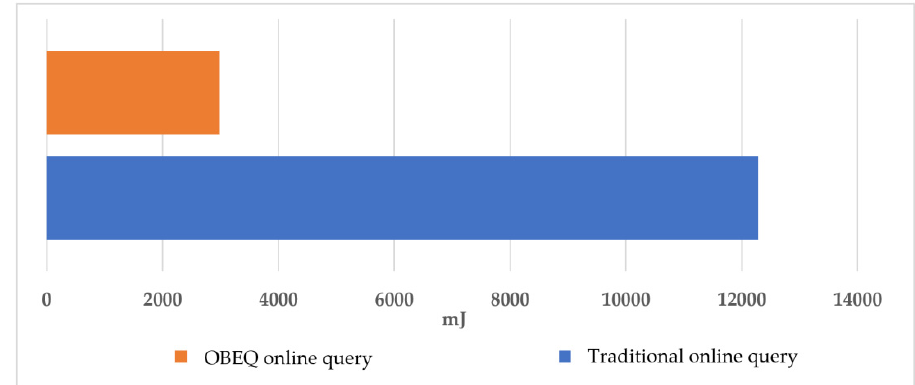
Figure 13. The power consumption of querying all online data.